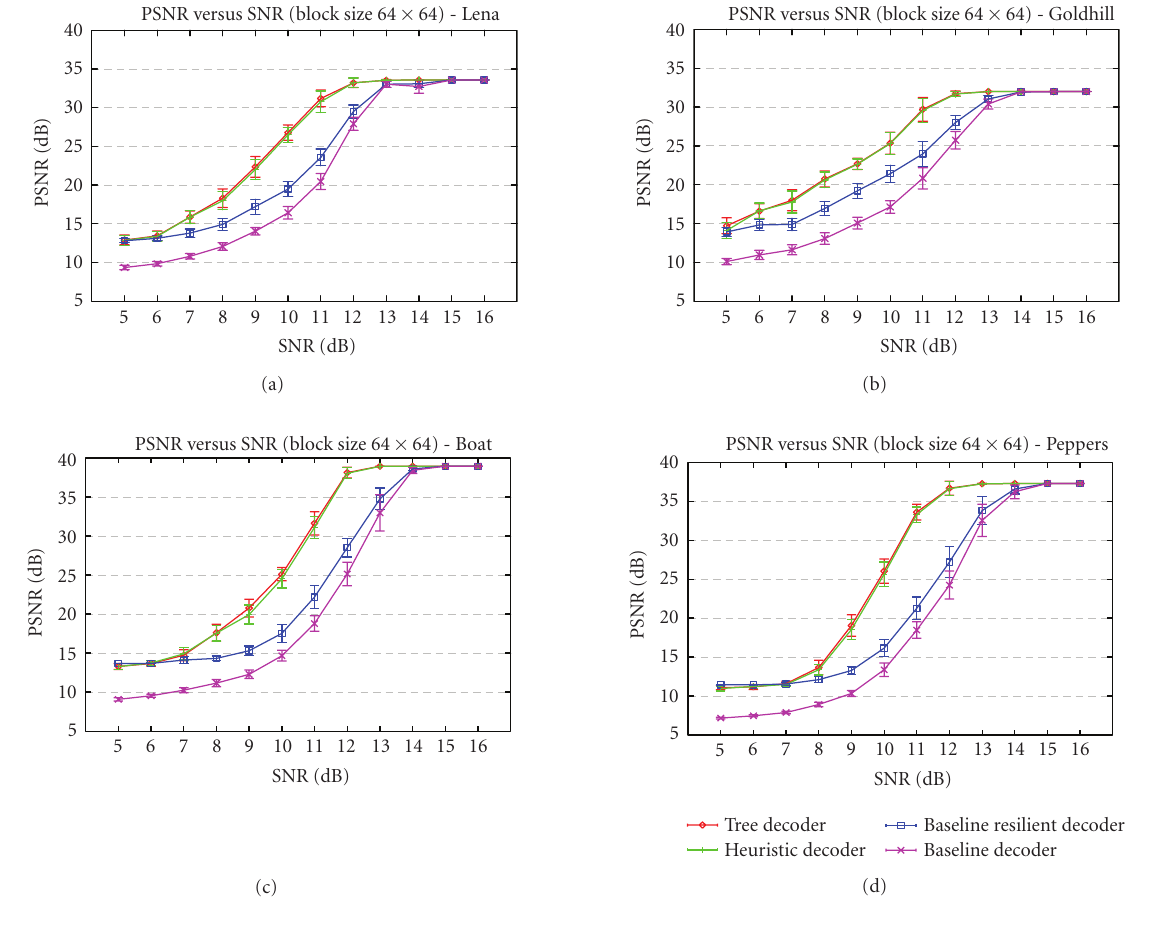
Figure 4: Comparison between